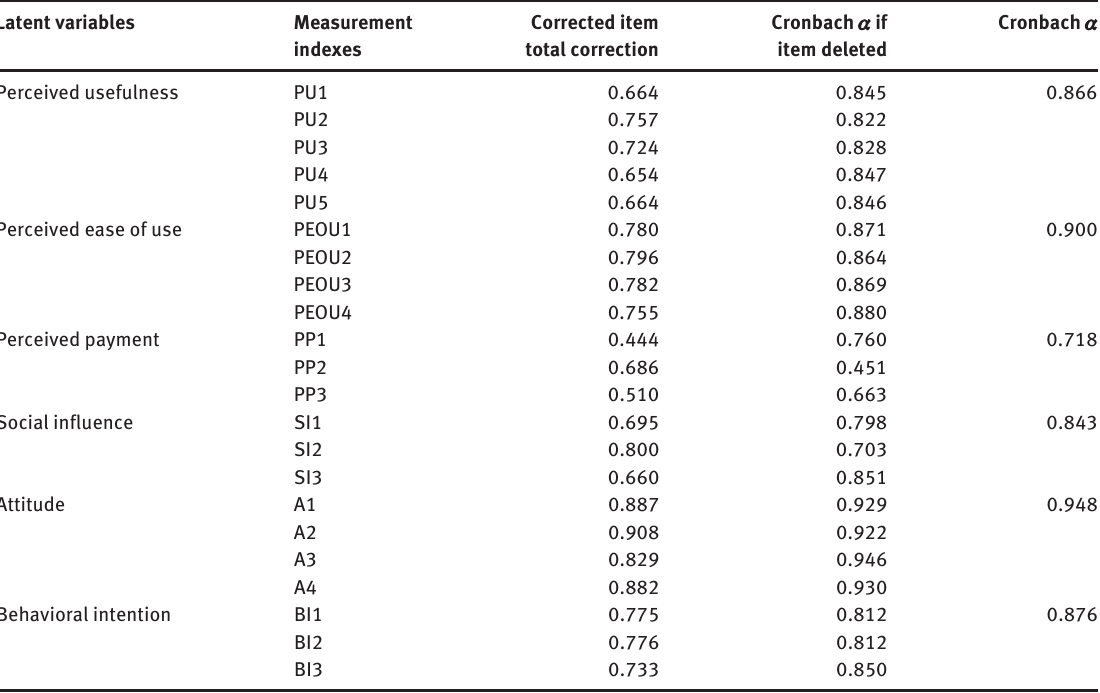
Table 1. Questionnaire Cronbach α Statistical Table.